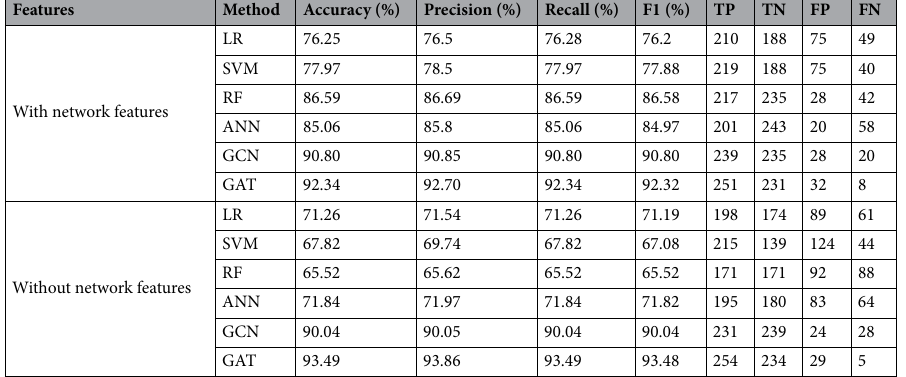
Table 3. Performance of models based on CVD test data. TP, TN, FP and FN stand for True Positive, True Negative, False Positive and False Negative, respectively.